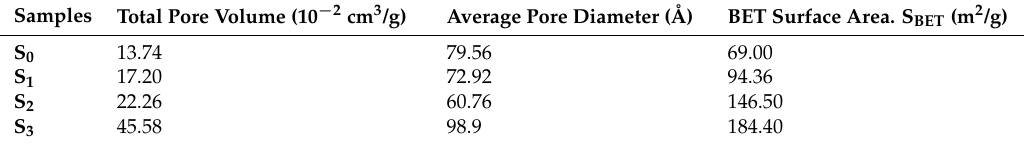
Table 2. Textural properties of raw material (S 0 ) and acid-activated clay samples (S 1 , S 2 , S 3